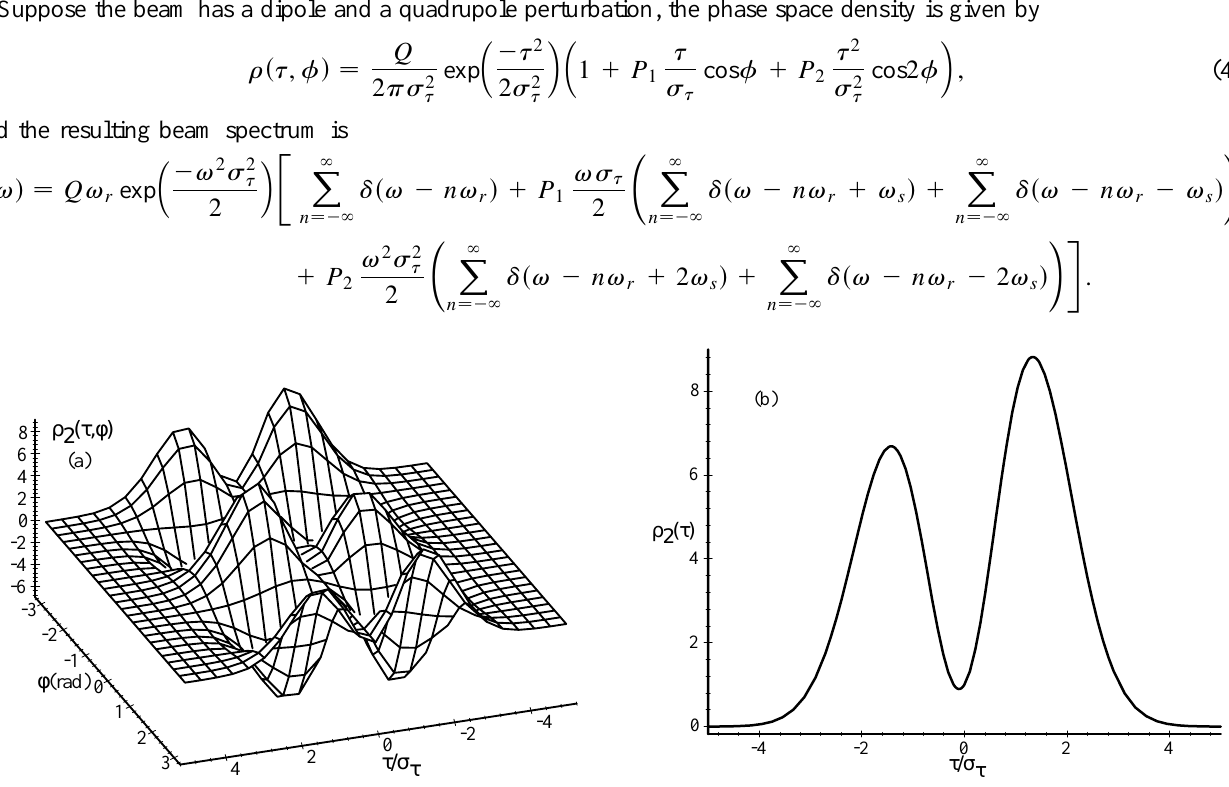
FIG. 4. (a) A phase space plot of the dipole and quadrupole perturbation [Eq. (4)], where r 2 (cid:1) t , f (cid:2) (cid:1) 2 r (cid:1) t , f (cid:2) ps 2 factors P 1 (cid:1) 2 and P 2 (cid:1) 10 . (b) A two-dimensional picture for the bunch distribution in (a) when r 2 (cid:1) t (cid:2) (cid:1) r 2 (cid:1) t , f (cid:1) 0 (cid:2)